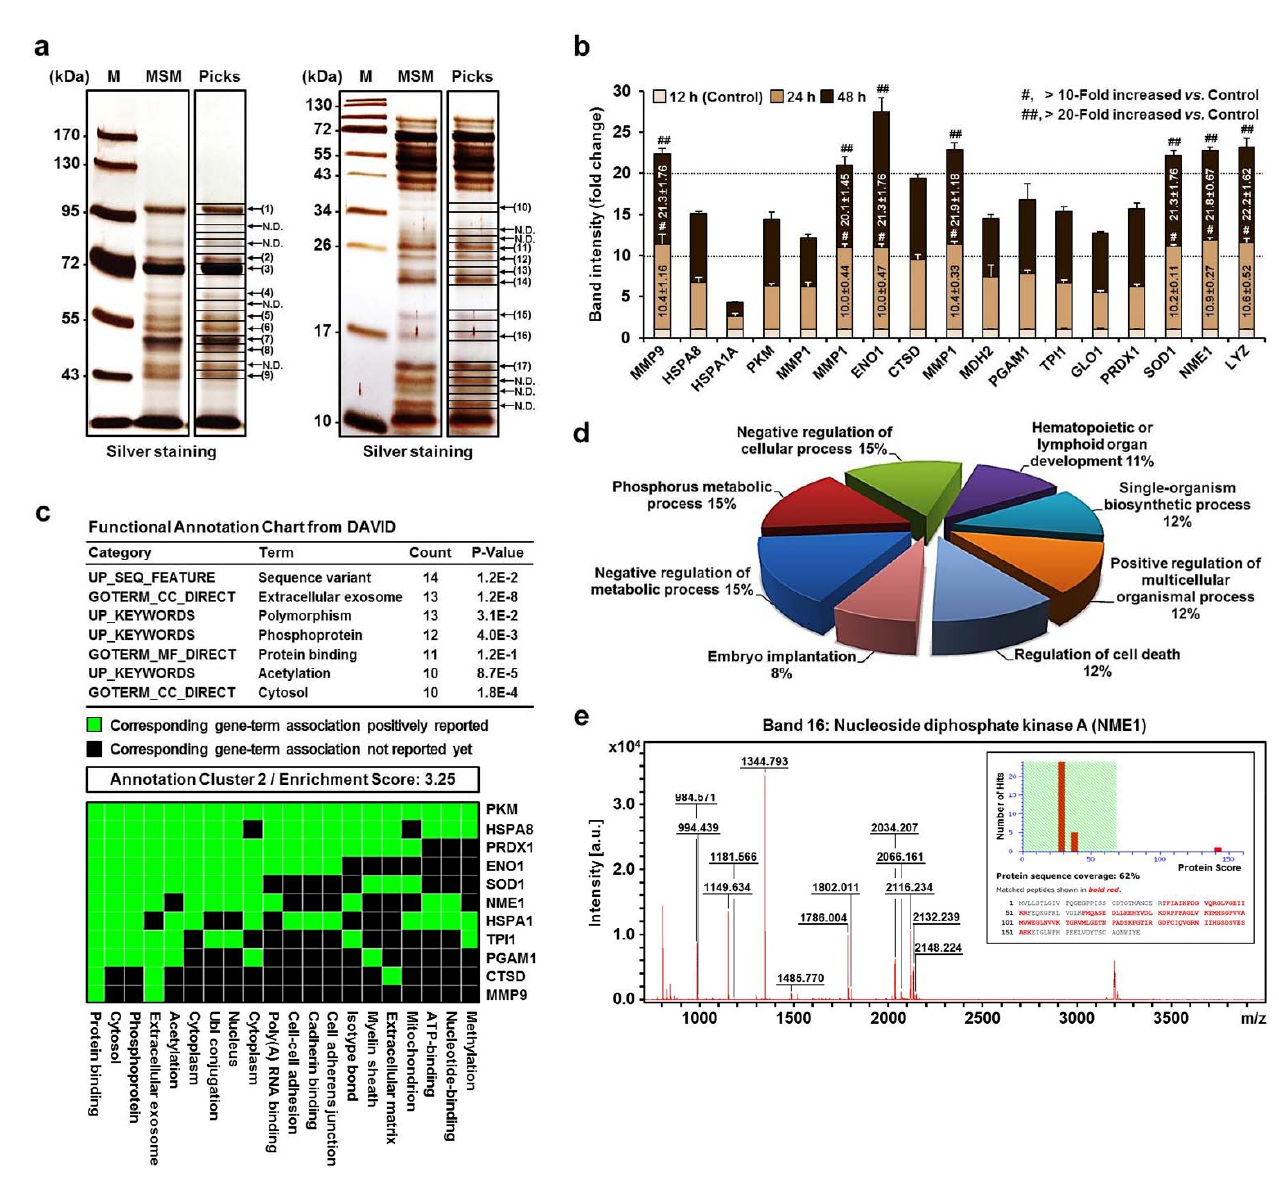
Figure 2. SDS-PAGE analysis and verification of high-abundance proteins in MSM. ( a ) SDS-PAGE and silver staining: pre-stained protein size marker (lane M), secretomes from cultured medium of active MPs (lane MSM), and sample picking from SDS-PAGE gel spots for peptide mass fingerprinting (PMF) analysis (lane Picks). N.D., not detected. ( b ) Quantification of protein bands from SDS-PAGE gels using Image J software. Data are presented as mean fold changes ± SD ( n = 3; #, more than 10-fold increase versus the control, p < 0.05; ##, more than 20-fold increase versus the control, p < 0.05). ( c ) Two clusters were identified using the DAVID functional annotation clustering tool. Annotated cluster represents a kappa value > 0.35 and overlap = 3. Similarity scores ranged from high (>1) to low enrichment (<0.25). ( d ) Illustration of identified proteins analyzed by gene ontology tool. ( e ) PMF spectrum of NME1. Spectral masses (in mass per charge unit, m / z ) obtained by MALDI-TOF MS were analyzed by bioinformatics using the Mascot and Profound search engines. The x -axis represents the mass-to-charge ratio ( m / z ), and the y -axis represents the relative abundance. The probability-based Mowse scores were obtained using the Mascot search engine. Among predicted proteins with differential Mowse scores shown as multiple bars on the x -axis, only proteins with Mowse scores > 68 were considered significant, which was 142 ( p < 0.05) for NME1 protein. Red marks indicate peptides identified by mass fingerprinting that match calculated molecular weights. All protein identifications are provided in Supplementary Figure S2 and Table S2.